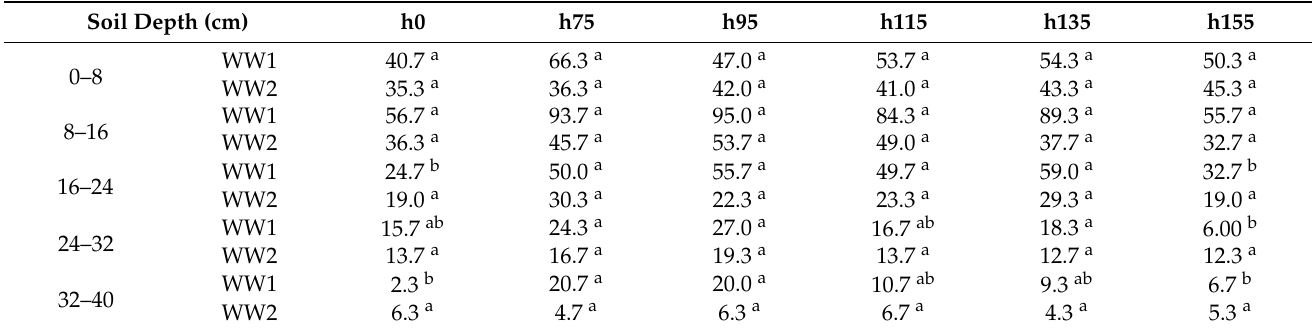
Table 1. Number of roots of winter wheat from two growing seasons.